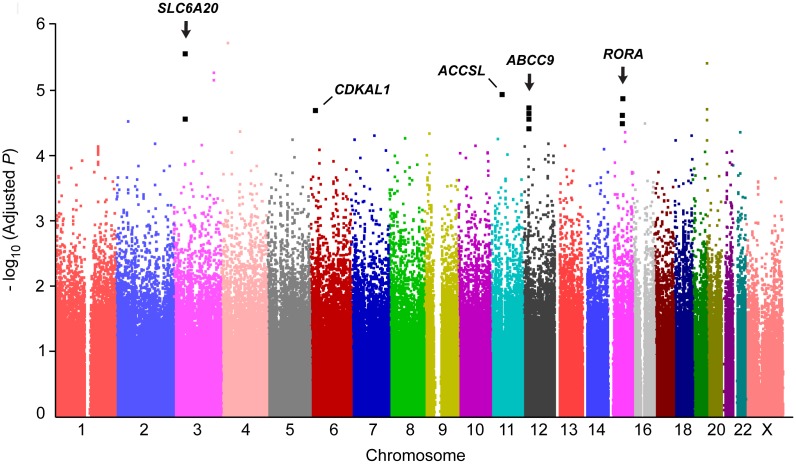
Result of the analysis adjusted by RET-CSGALNACT2-RASGEF1A and NRG1 and top SNPs within the gene region.The adjP-value (y-axis) after adjustment by rs2435357, rs1800860, and rs7078220 on RET-CSGALNACT2-RASGEF1A region and rs16879552 on NRG1 is plotted against its physical position on successive chromosomes.